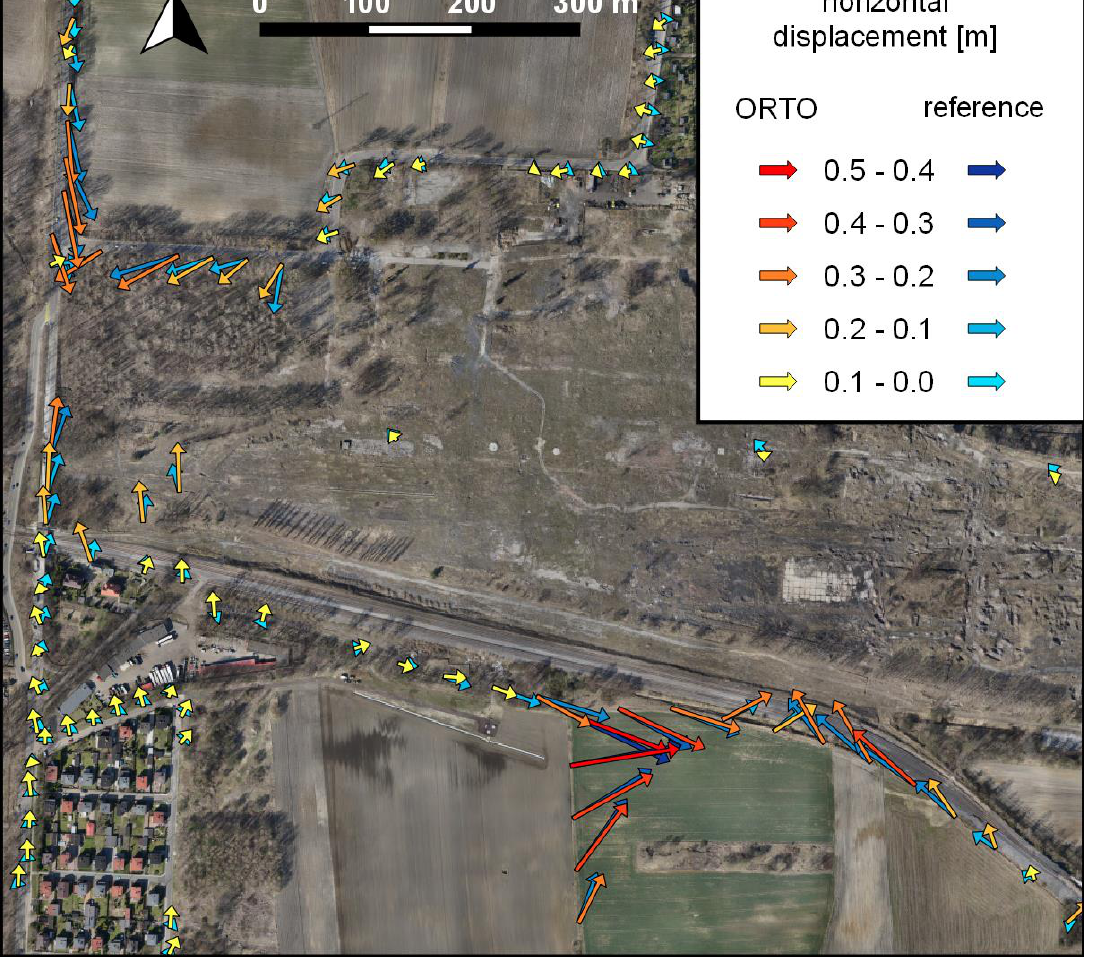
Figure A1. Horizontal displacements determined via the UAV photogrammetric method (ORTO method) and reference measurements at the Piekary site.